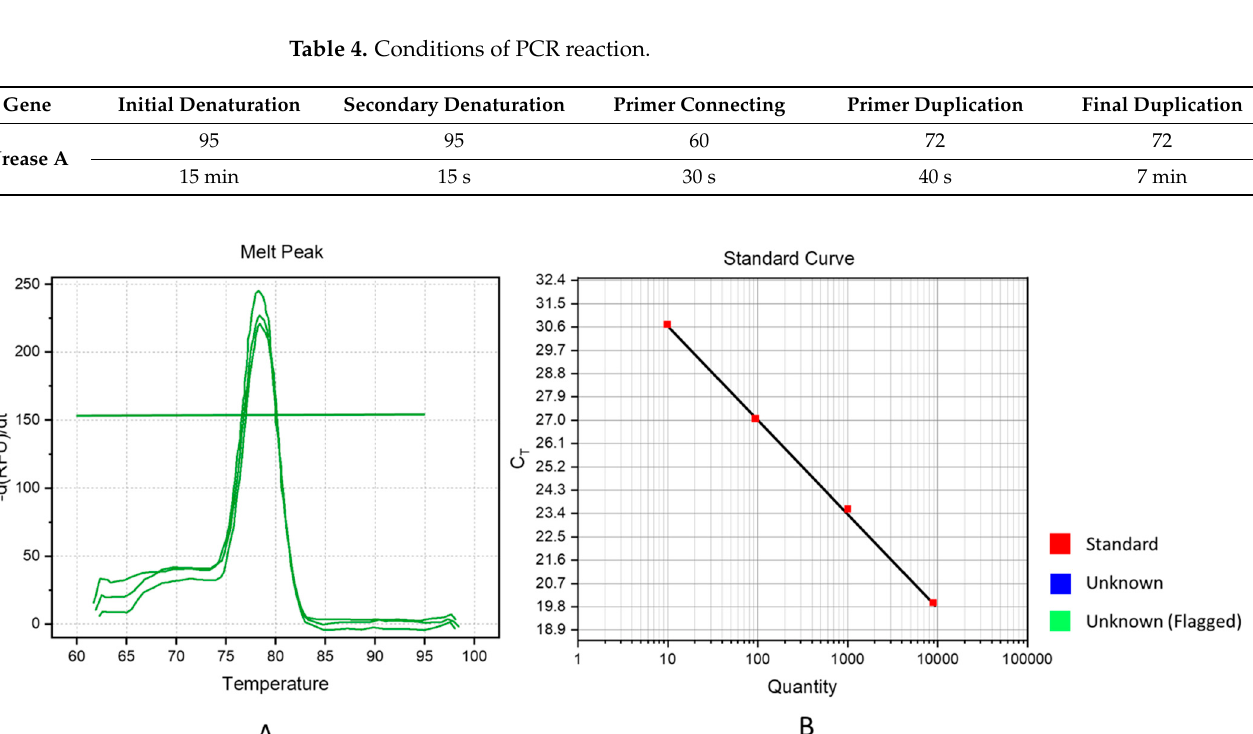
Table 3. Sequence and melting temperature of urease and gyrB genes, with primer size used in Quantitative Real ‐ Time PCR method.